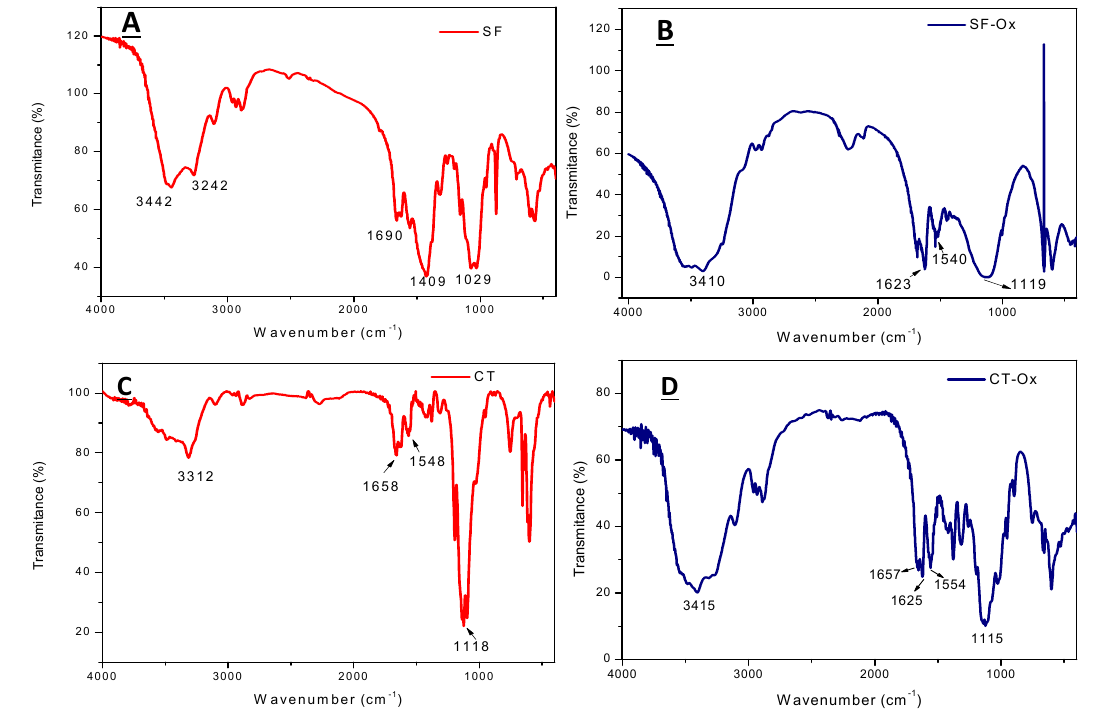
Figure 4. FTIR spectra of silk-fibroin ( A ) and silk-fibroin-Oxone ® ( B ); chitin ( C ) and chitin-Oxone ® ( D ).